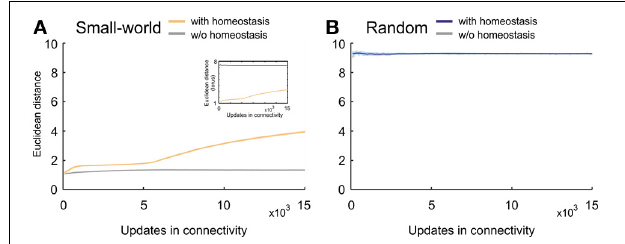
FIGURE 7 | Average Euclidean distance between pre- and postsynaptic neurons for every synapse during network development. (A) Small-world networks with (orange) and without (gray) homeostasis in electrical activity. (B) Random networks with (blue) and without (gray) homeostasis in electrical activity. Means over five simulations per scenario. Shadings of the curves indicate standard deviations. Inset in (A) depicts the change in Euclidean distances for homeostatic random (blue) and homeostatic small-world networks (orange) with torus boundary